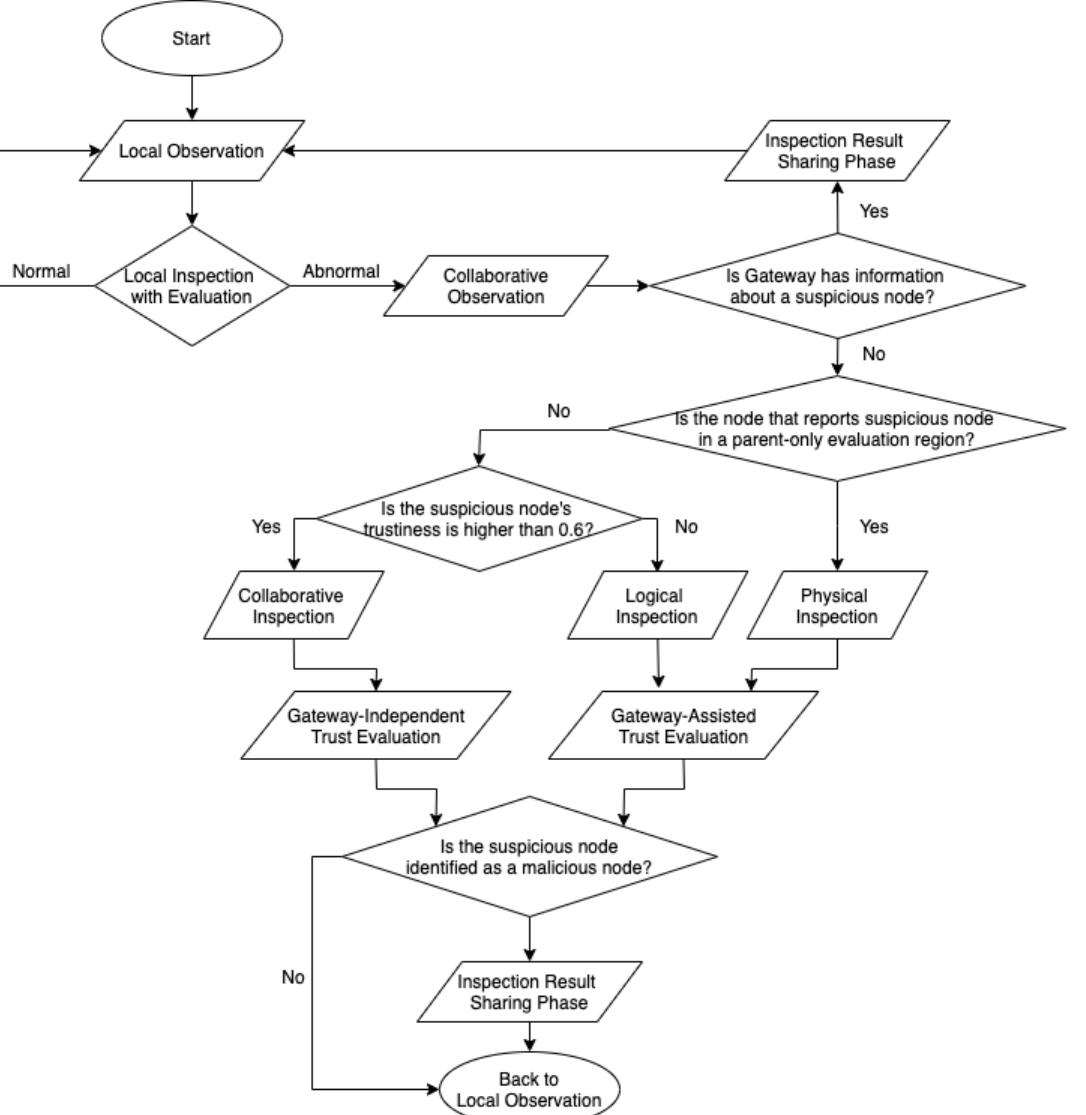
Figure 3. Flowchart of our trust evaluation